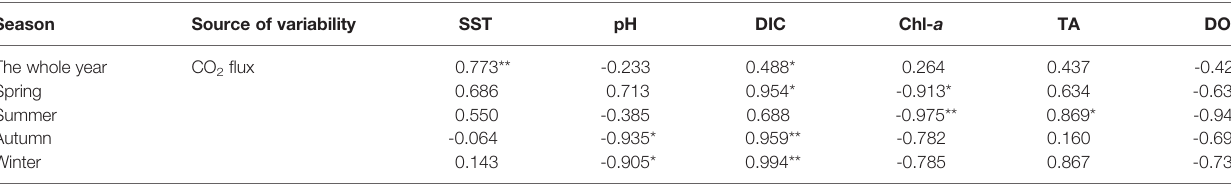
TABLE 3 | Pearson correlation coef fi cients between CO 2 sea – air fl ux and environmental factors. Season Source of